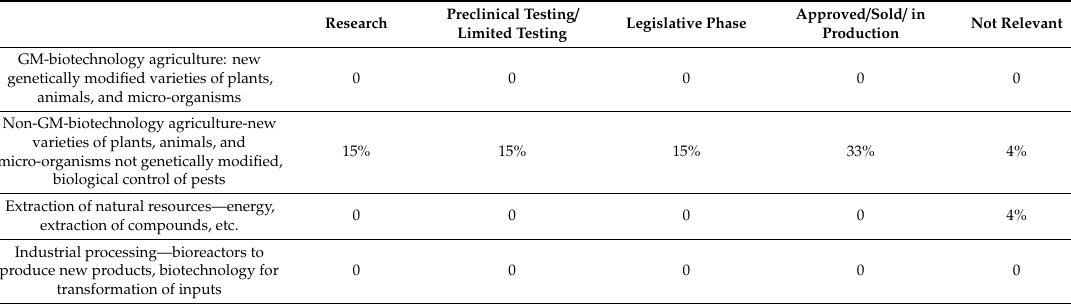
Table 2. Types of biotechnological methods applied to the agri-food sector.